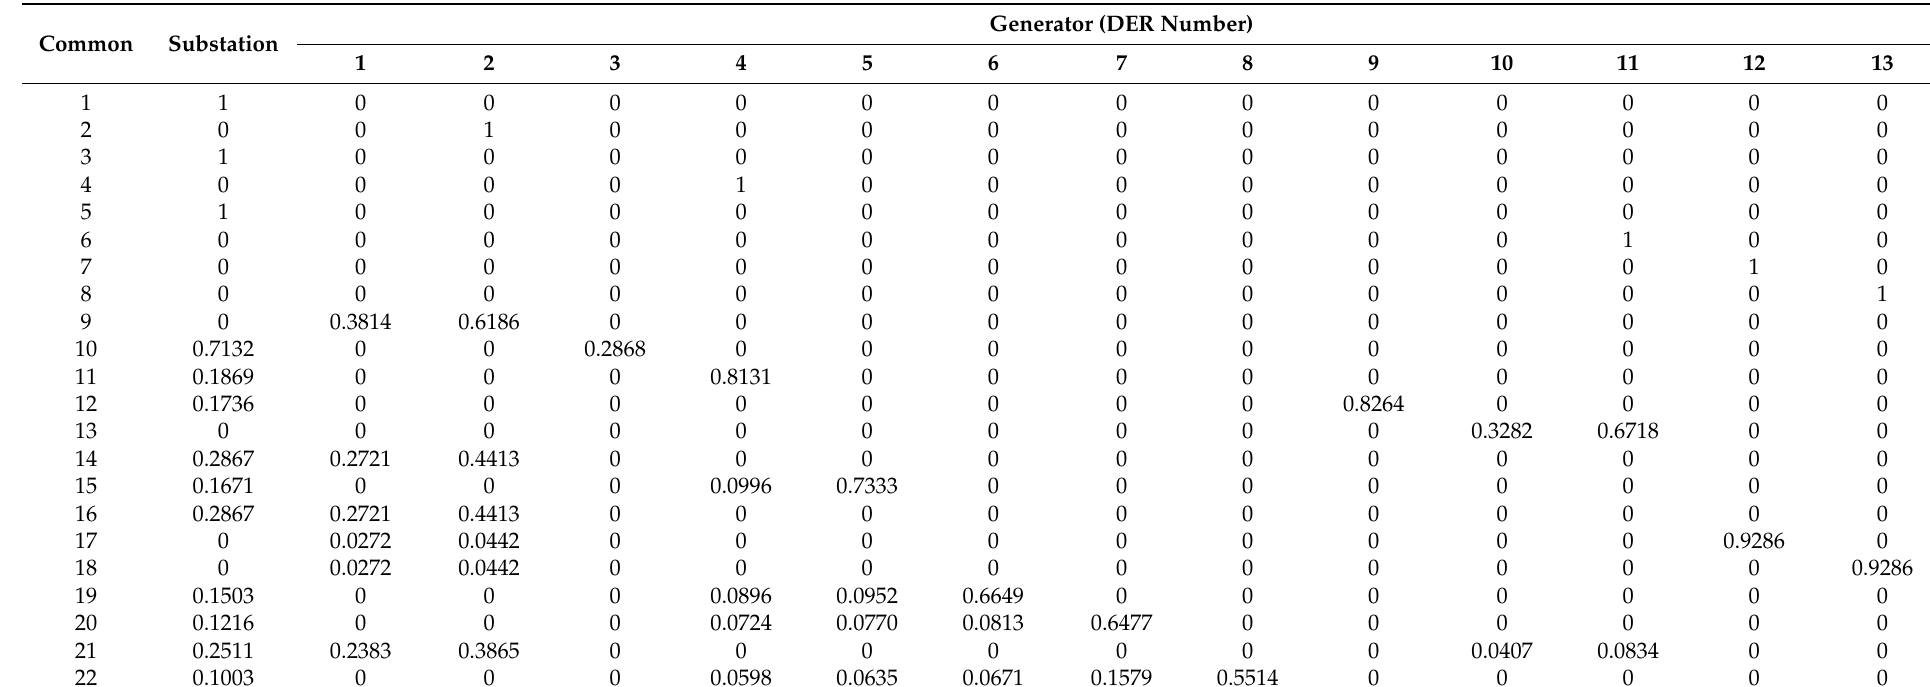
Table 4. The relative contribution of generators to